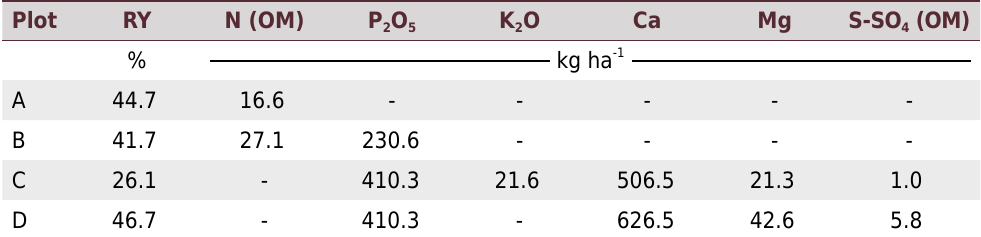
Table 8. Relative yield (RY) and recommended application rates of nitrogen (N), phosphorus (P 2 O 5 ), potassium